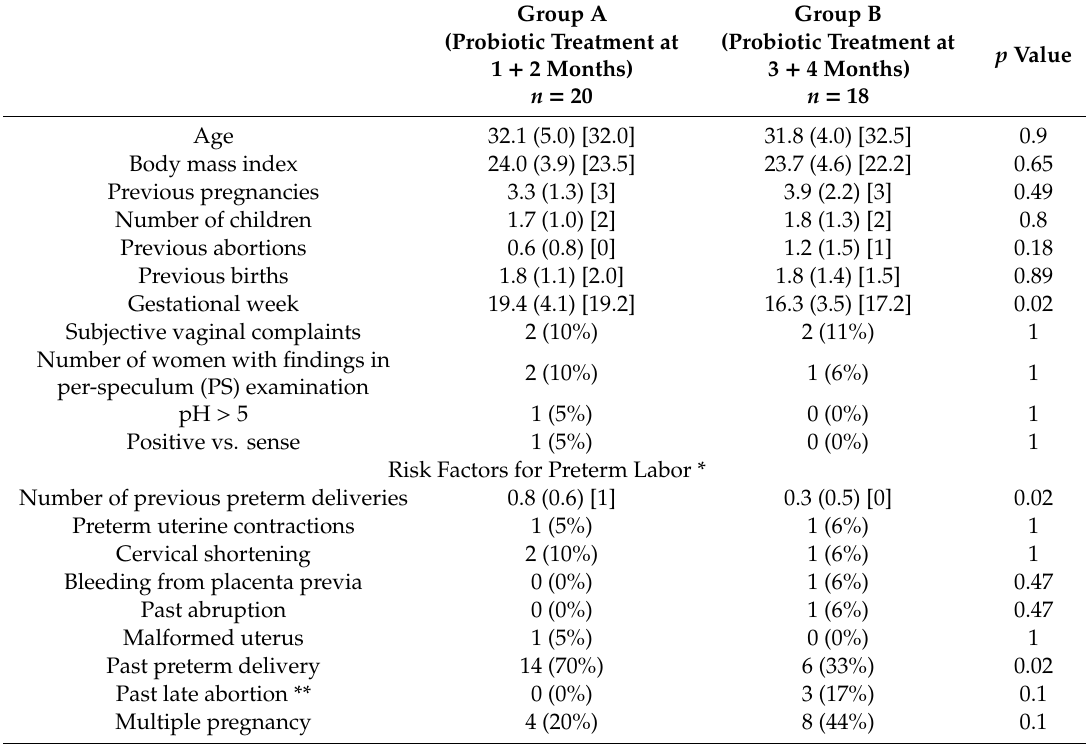
Figure 2. Patients’ flow chart. Figure 2. patients' flow chart Table 1. Baseline characteristics of study Table 1. Baseline characteristics of study participants.